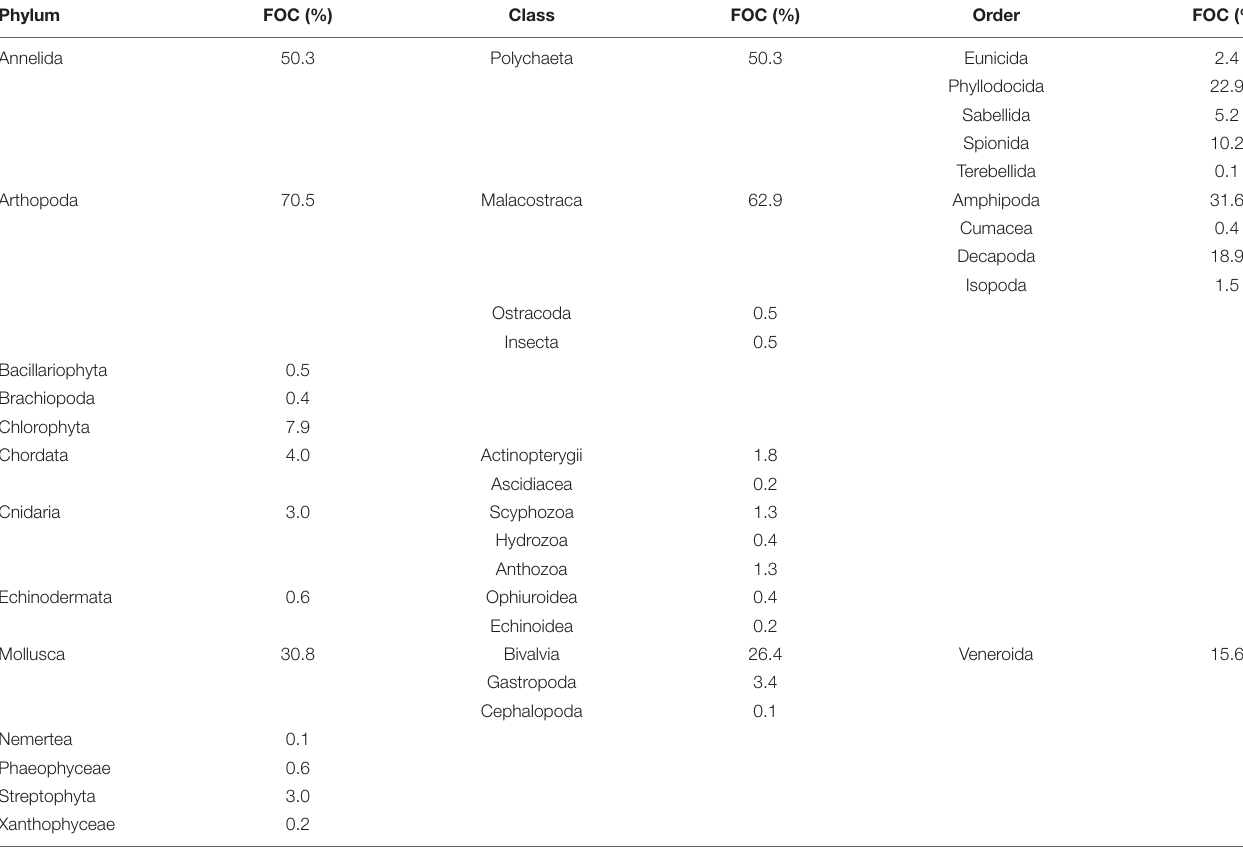
TABLE 2 | Frequency of occurrence (FOC) of prey groups in gut contents of Yellowfin Bream in primary diet data (Pease et al., 1981). Phylum FOC (%) Class FOC (%)